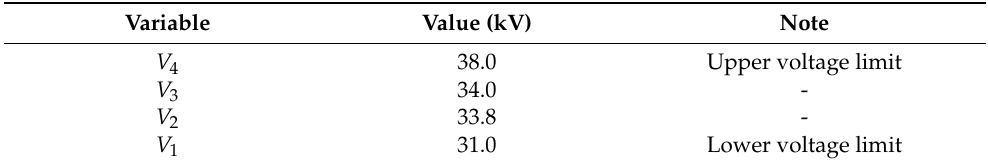
Table 2. EMS configuration for operation in voltage control mode .